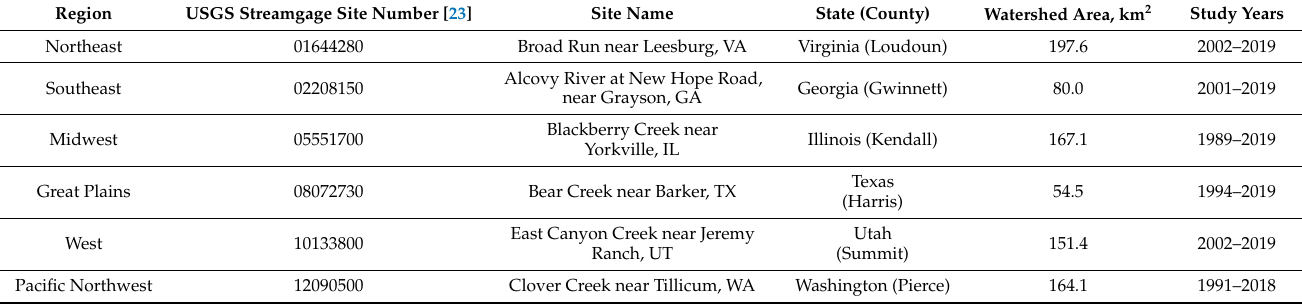
Figure 1. Locations of six representative study watersheds ( a ) with land cover maps and urban area for 2019 with urban area percent (D) for start/end study years across six broad hydroclimate regions of the conterminous United States ( b – g ). The green stars ( b – g ) represent the outlets of the watersheds. Land cover data sourced from the Land Change Monitoring, Assessment, and Projection (LCMAP) Collection 1.1 (https://www.usgs.gov/core-science-systems/eros/lcmap, accessed on 15 June 2022). Table 1. Summary of study watersheds including the U.S. Geological Survey (USGS) streamgage information, watershed area, and study years.